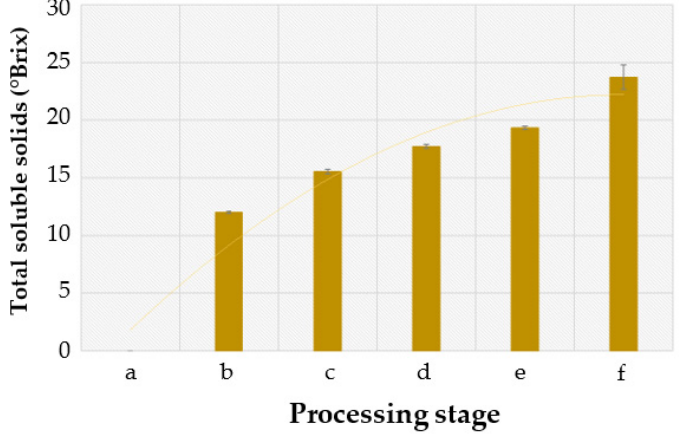
Figure 2. Evolution of TSS (°Brix) after ( a ) 0 h, ( b ) 12 h, ( c ) 24 h, ( d ) 36 h, ( e ) 48 h of the carob pods maceration in water, and ( f ) boiling for 10 min.